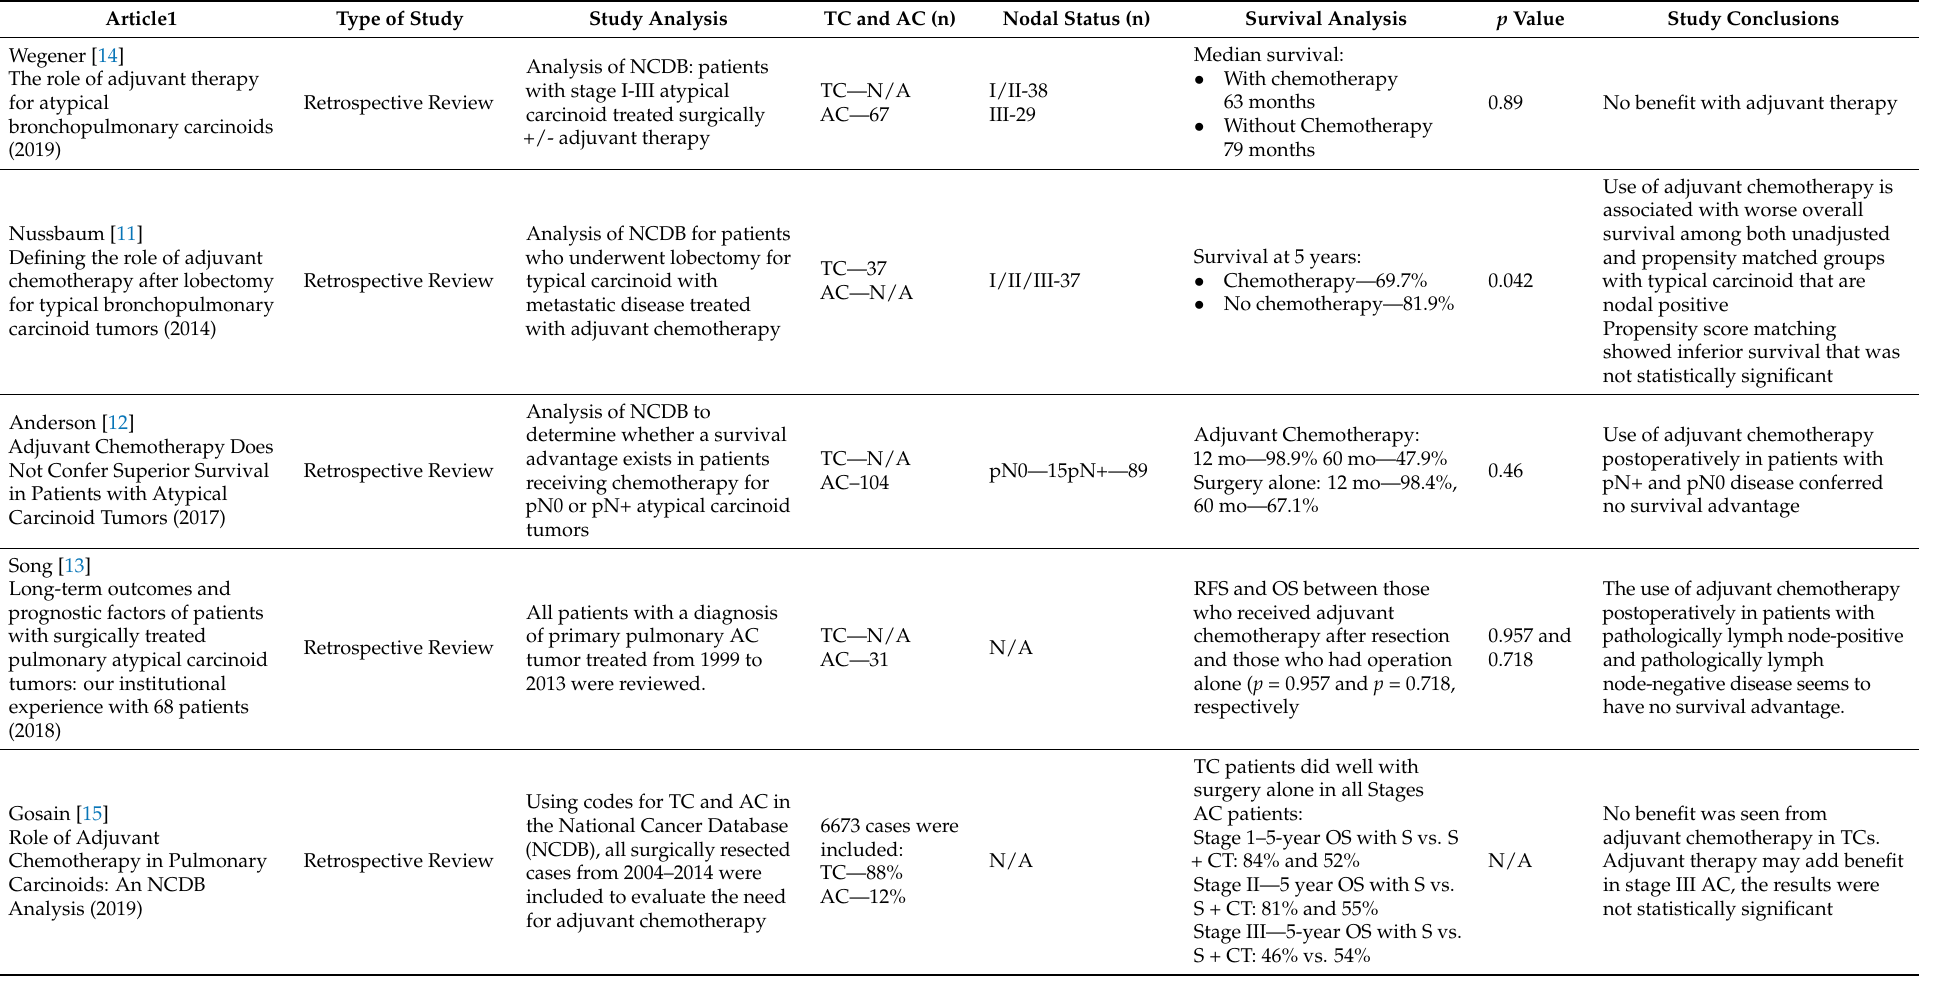
Table 1. Articles selected assessing survival benefit of individuals with typical and/or atypical carcinoid who underwent surgical resection and received adjuvant chemotherapy. Abbreviations: Progression-Free Survival (PFS); Overall Survival (OS); Median Overall Survival (MOS); Typical Carcinoid (TC); Atypical Carcinoid (AC); S—Surgery; S + CT—Surgery +